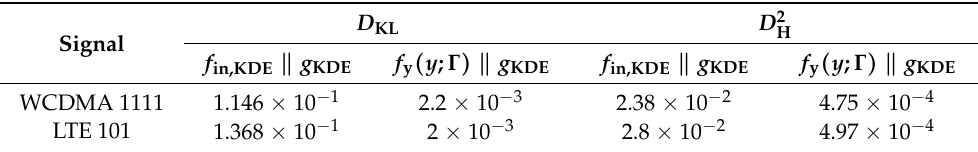
Table 1. Comparison of probability density functions (PDFs) for noiseless case and g = g ’ = 0.92 dB and θ = θ ’ = − 6 degrees.